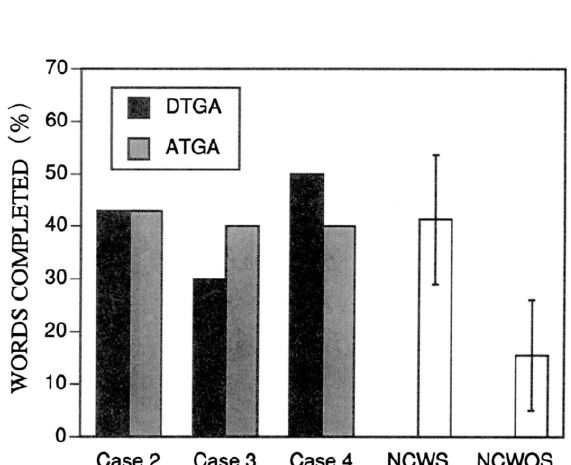
FIG. 3. Word stem completion performance of patients during (DTGA) and after TGA (ATGA) and age-matched normal control males. NCWS, normal controls with prime stimulations; NCWOS, normal controls without prime stimulations (baseline completion rates). Bars show standard errors of the